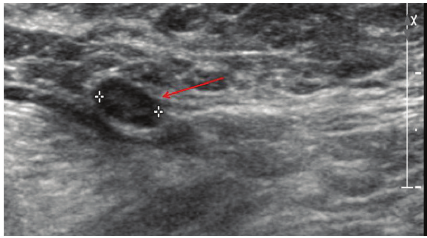
Figure 2: A nine-millimeter indeterminate left axillary lymph node.